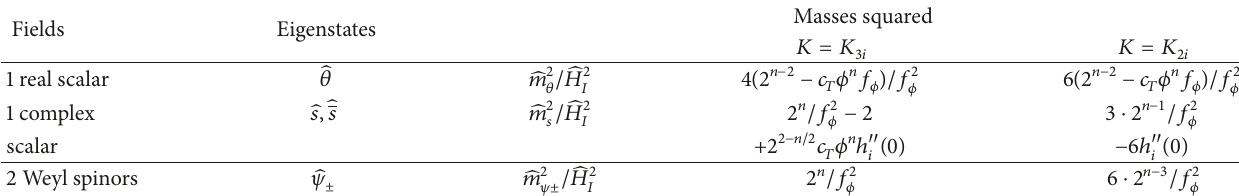
Table 2: Mass-squared spectrum for 𝐾 = 𝐾 3𝑖 and 𝐾 2𝑖 along the inflationary trajectory in (46).